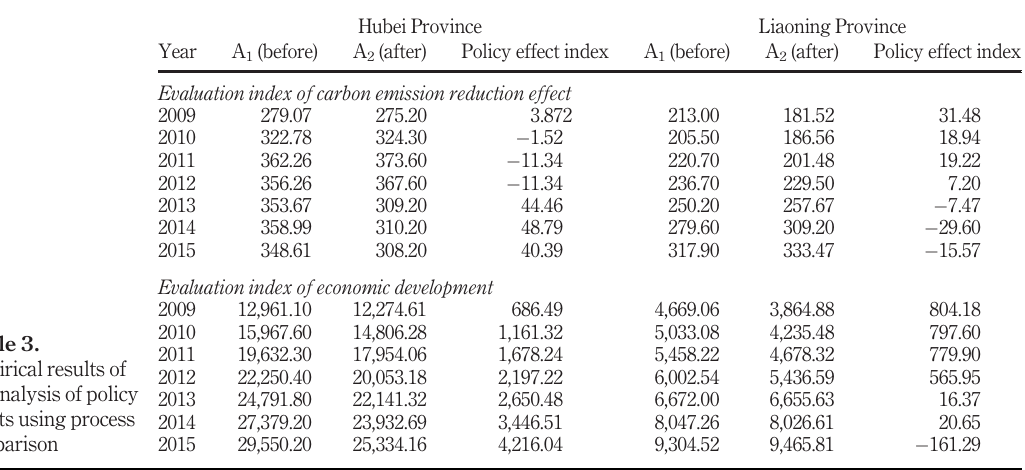
Table 3. Empirical results of the analysis of policy effects using process